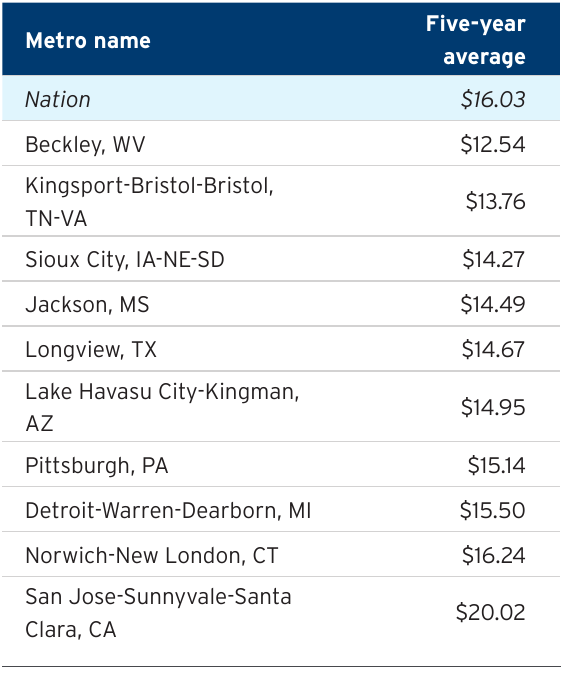
Note: Dollar values are adjusted to 2016 real dollars Source: Based on U.S. Census Bureau, American Community Survey 1-year estimates (2012-2016), Table S2002, adjusted by Bureau of Economic Analysis’ Regional Price Parities for “all